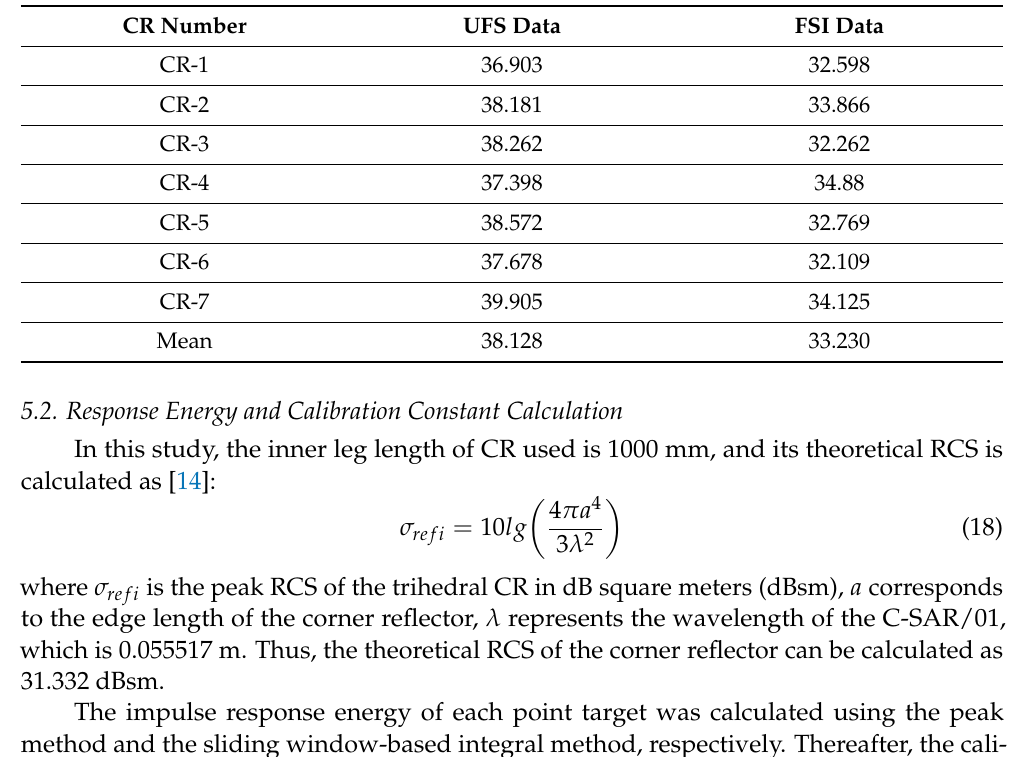
Table 5. Statistics of each CR for UFS and FSI mode data (/dB).